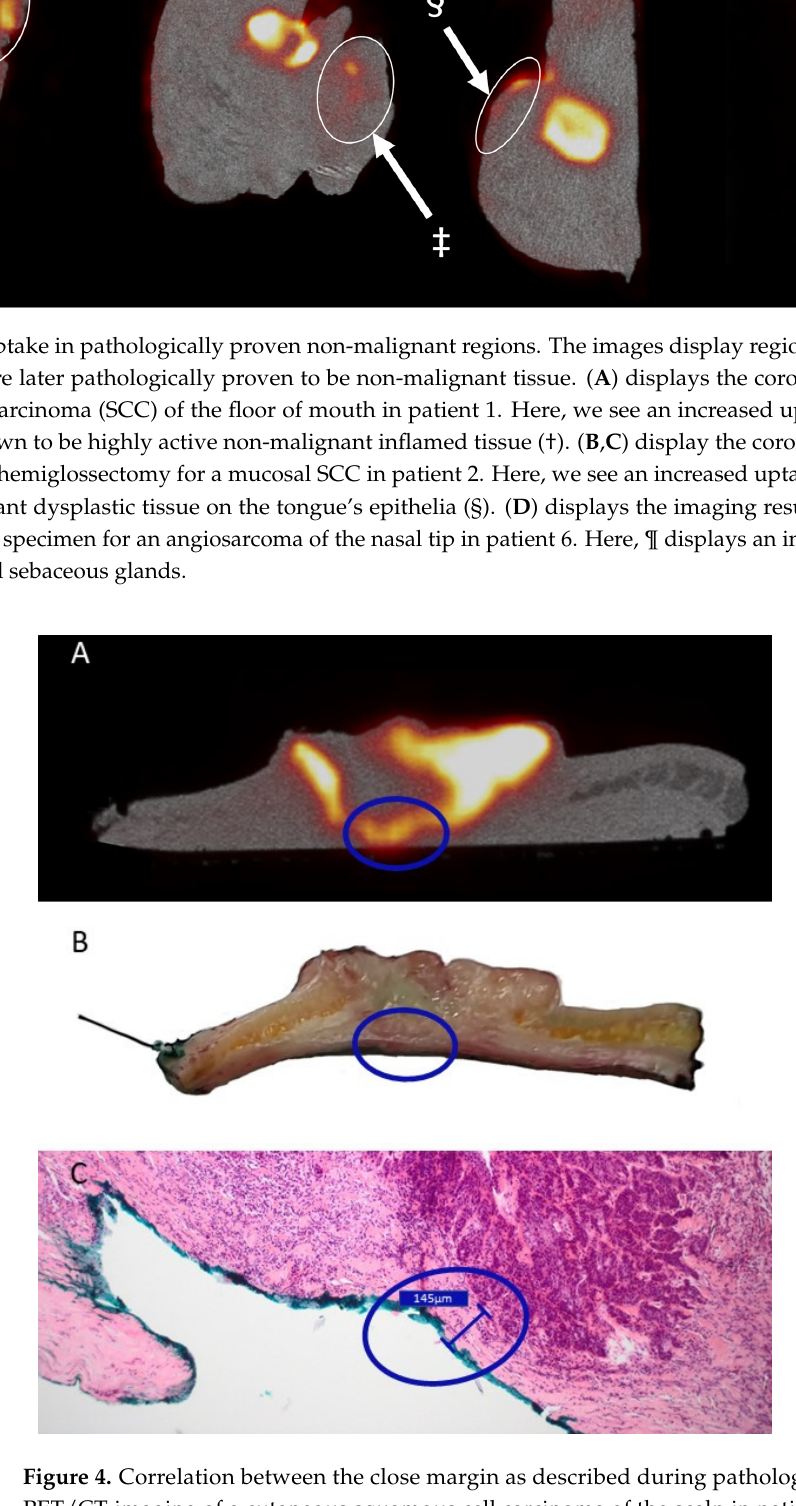
Figure 4. Correlation between the close margin as described during pathological assessment and PET/CT-imaging of a cutaneous squamous cell carcinoma of the scalp in patient 3. The blue circle